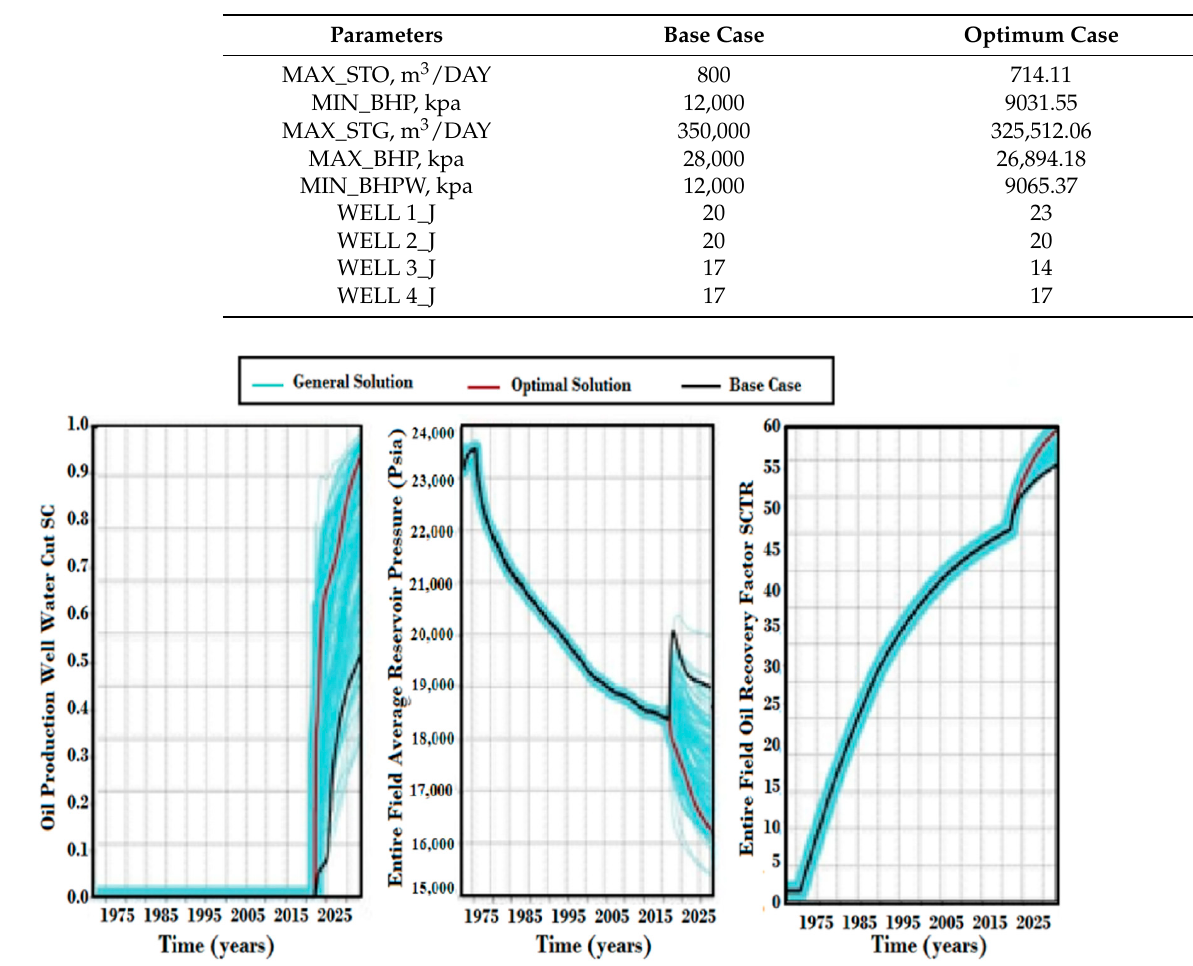
Figure 14. Well locations in PUNQ reservoir for TC-GDWS-AGD. Table 5. Base-case and PSO-derived optimal-case operational decision variable values for TC-GDWS recovery optimization applied to scenario 2.